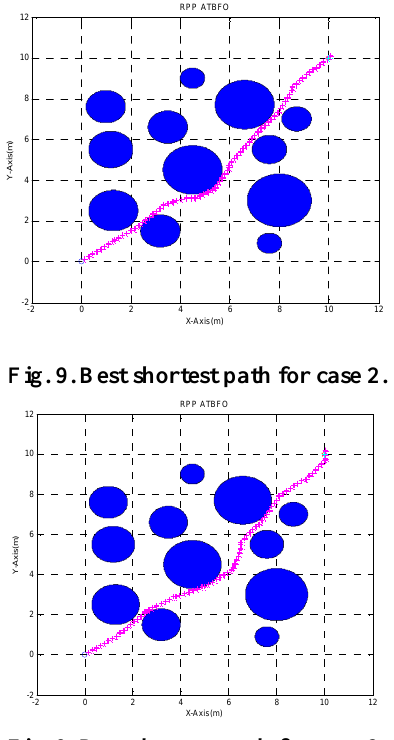
Fig. 9. Best shortest path for case 2.